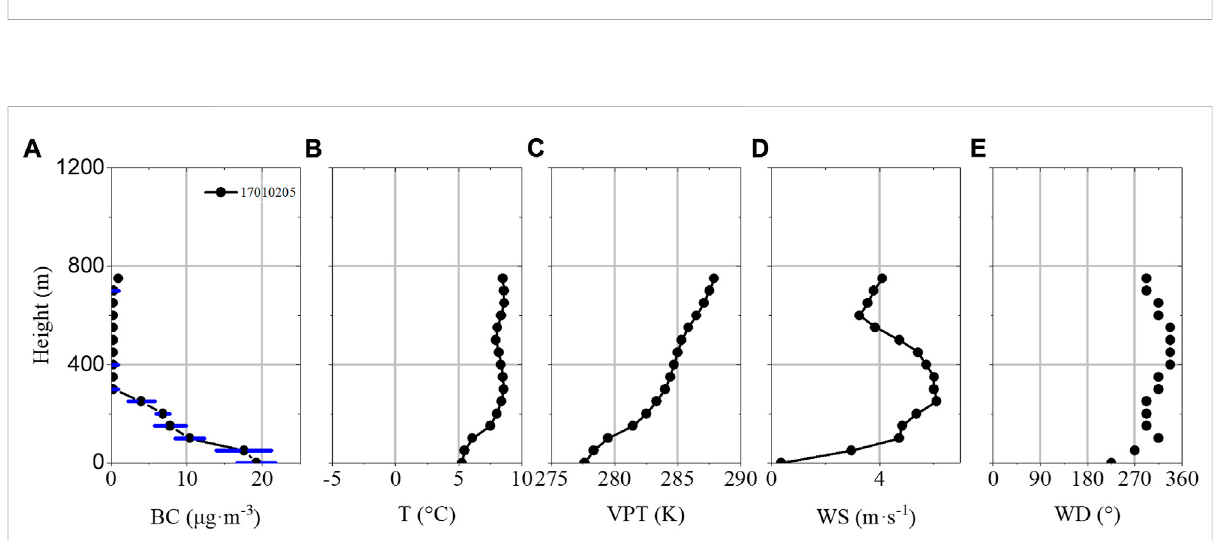
FIGURE 8 Dynamic controlled unstableboundary BC,T, VPT, WSand WD contours. The black line indicates thecontoursofeach elementat2017010211. Blue lines are BC error bars. (A) black carbon aerosol vertical pro fi le, (B) temperature vertical pro fi le, (C) virtual potential temperature vertical pro fi le, (D) wind speed vertical pro fi le, (E) wind direction vertical pro fi le.